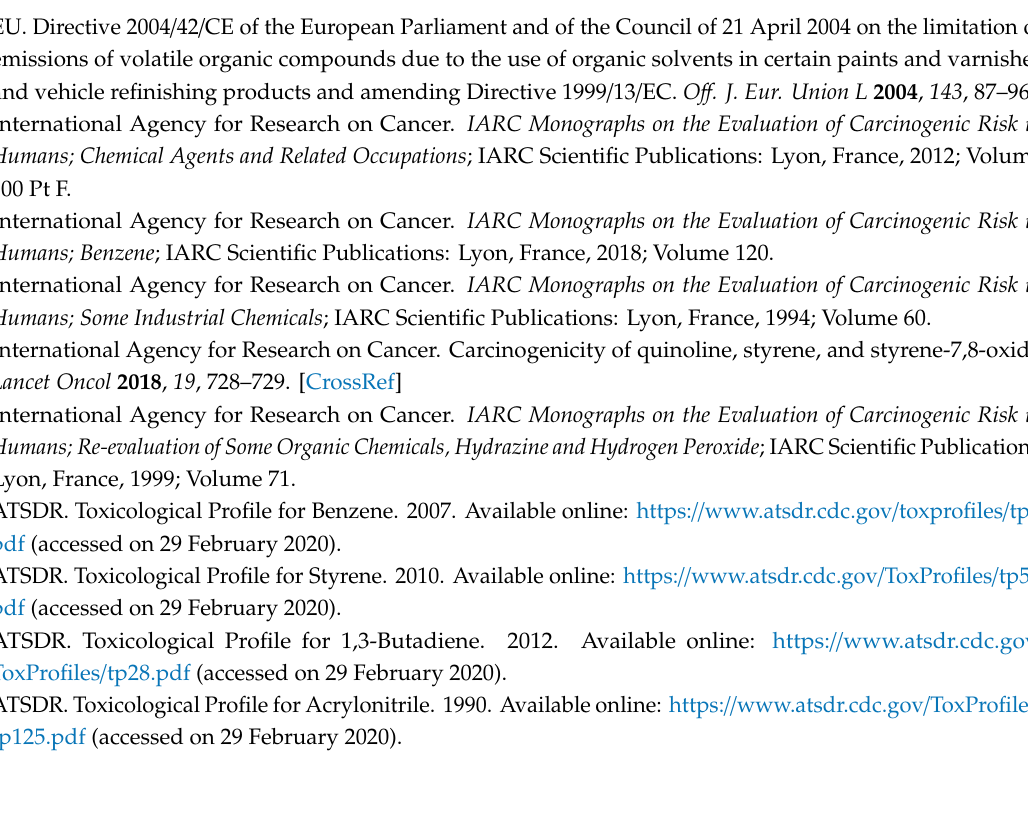
Table S1: Median, 5th and 95th percentile for the levels of mercapturic acids in subjects’ urine samples, expressed as µ g / L, after grouping by controls and workers. For each compound, the limit of quantitation (LOQ) is also reported, along with the percentage of quantified samples. Finally, p -value of the student’s T-test performed on log 10 transformed values is reported to evaluate di ff erences between the two